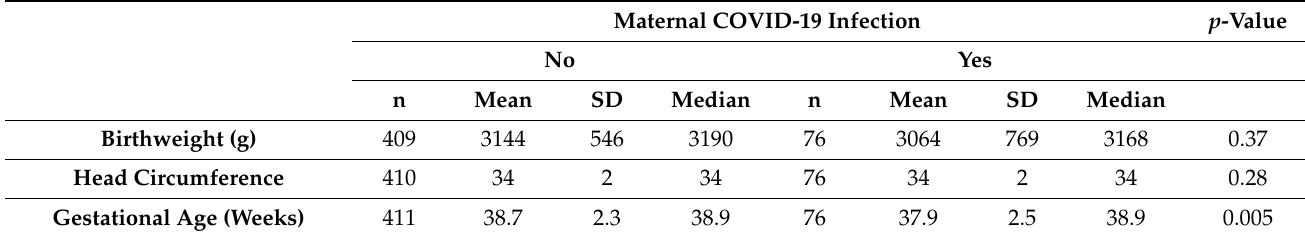
Table 4. Infant growth parameters and maternal COVID-19 status.